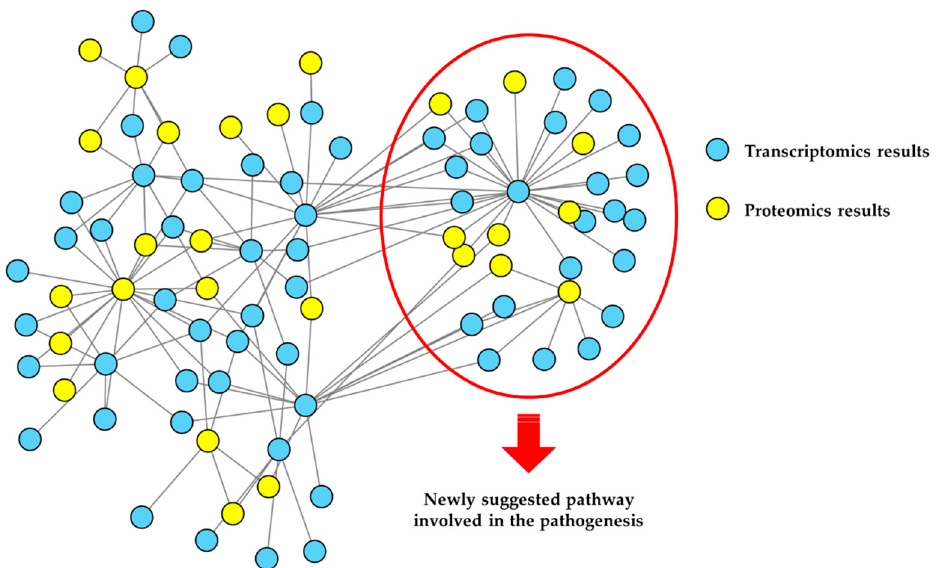
Figure 2. An example of network-based functional proteomics and integrated omics, used to gain new insights into NDs pathobiology . Results (e.g., gene products differentially expressed) coming from different omics strategies can be used to build a network model of the ND under investigation. Edges may represent, as in this case, protein-protein interactions (PPIs). Various analyses, such as over-representation analysis after network clustering, can provide a functional interpretation of the results. In this example, proteins differentially expressed (blue nodes) or differentially abundant (yellow nodes), as observed by transcriptomics and proteomics experiments, are first interactors and strictly interconnected, suggesting that they take part in the same biochemical pathways. Evidenced nodes are involved in the same process (over-represented), suggesting their involvement in the ND pathobiology.